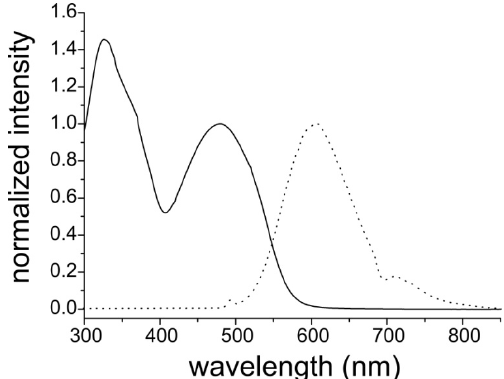
) and electrochemical (CH 3